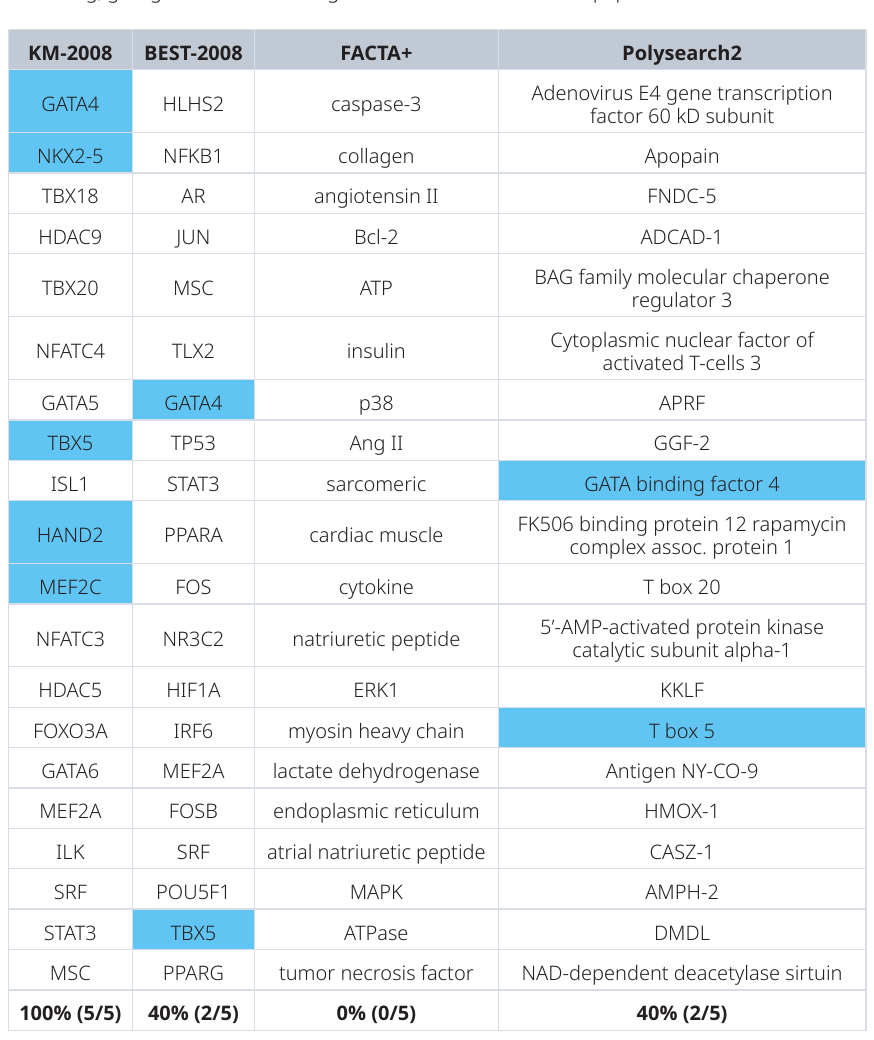
Table 2. Cardiomyocyte transcription factor search. Landmark factors are highlighted in blue and the bottom row shows Recall@20. Note that KinderMiner and BEST have been censored to articles published through 2008, whereas the other methods have no such censoring, giving them the advantage of access to the landmark papers and